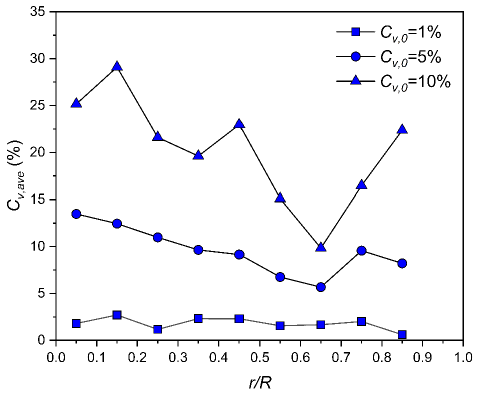
Figure 8. Effects of initial SVF on average SVF ( V mix ,0 = 4.0 m/s, d s = 15.0 mm).